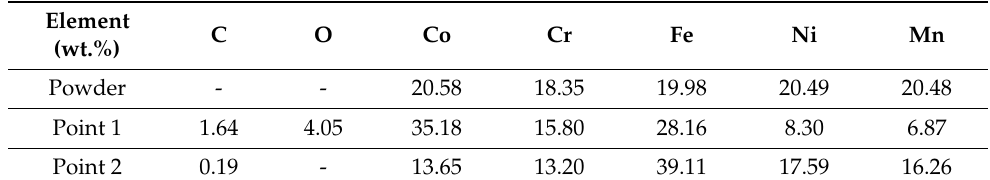
Figure 5. Point analysis of elements in CoCrFeNiMn coating prepared at 70 A plasma current: ( a ) coating, ( b ) composition of point 1, ( c ) composition of point 2. Table 4. Composition of the CoCrFeNiMn high entropy alloy powder and point analysis of elements in the HEA coating prepared at 70 A plasma arc current.